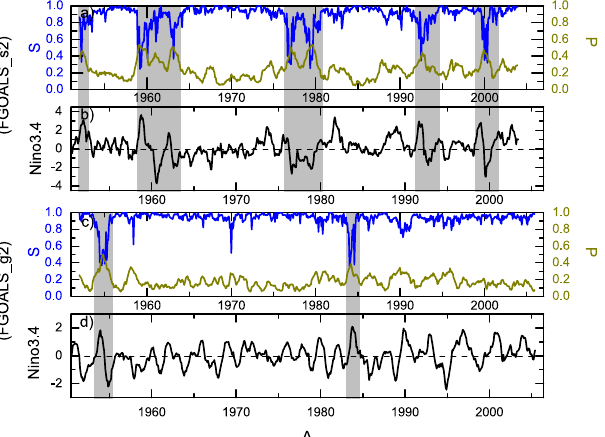
Figure 4. Simulated P , S , and Niño3.4 index in FGOALS_s2 and FGOALS_g2. ( a , b ) are the results from FGOALS_s2, while ( c , d ) are the results from FGOALS_g2. The gray areas highlight the cases when P , S , and the Niño3.4 index had good connections. FGOALS_s2 seems to exhibit better performance as the expected P / S reactions were simulated successfully in most cases. However, the P values from FGOALS_g2 seem to be underestimated. As a result, the network was unrealistically stable with high S